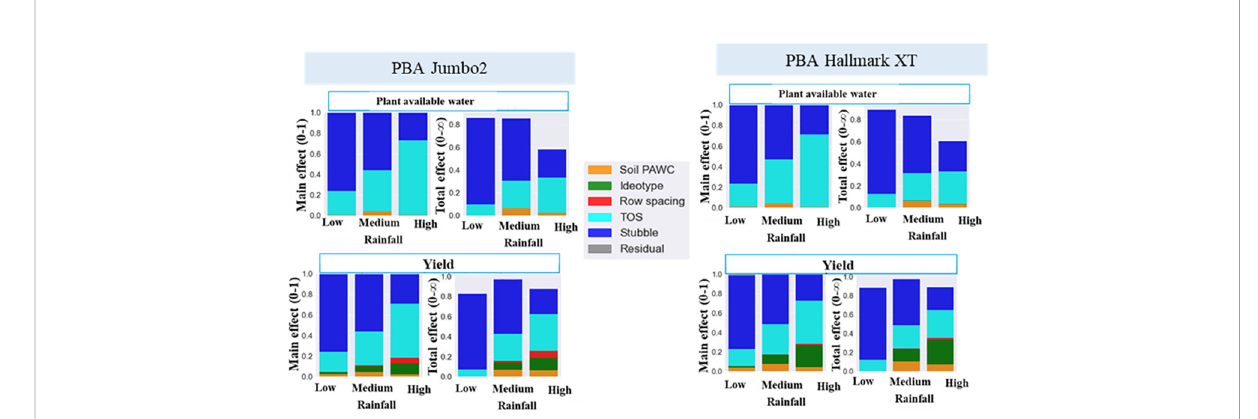
FIGURE 5 Drivers of plant available water and seed yield of lentils in low medium and high rainfall environments. PAWC, plant available water capacity; TOS, time of sowing. Ideotype was created by a ten percent increase (10%-40%) of individual trait (leaf size, RUE and HI rate) around baseline